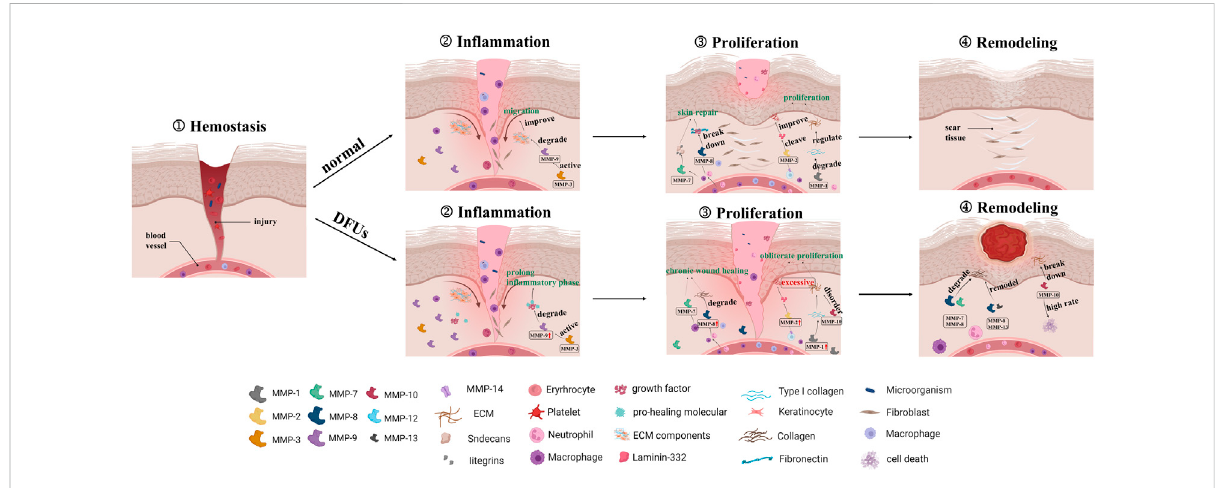
FIGURE 2 The graphical depiction of normal and chronic wound healing with dysregulated